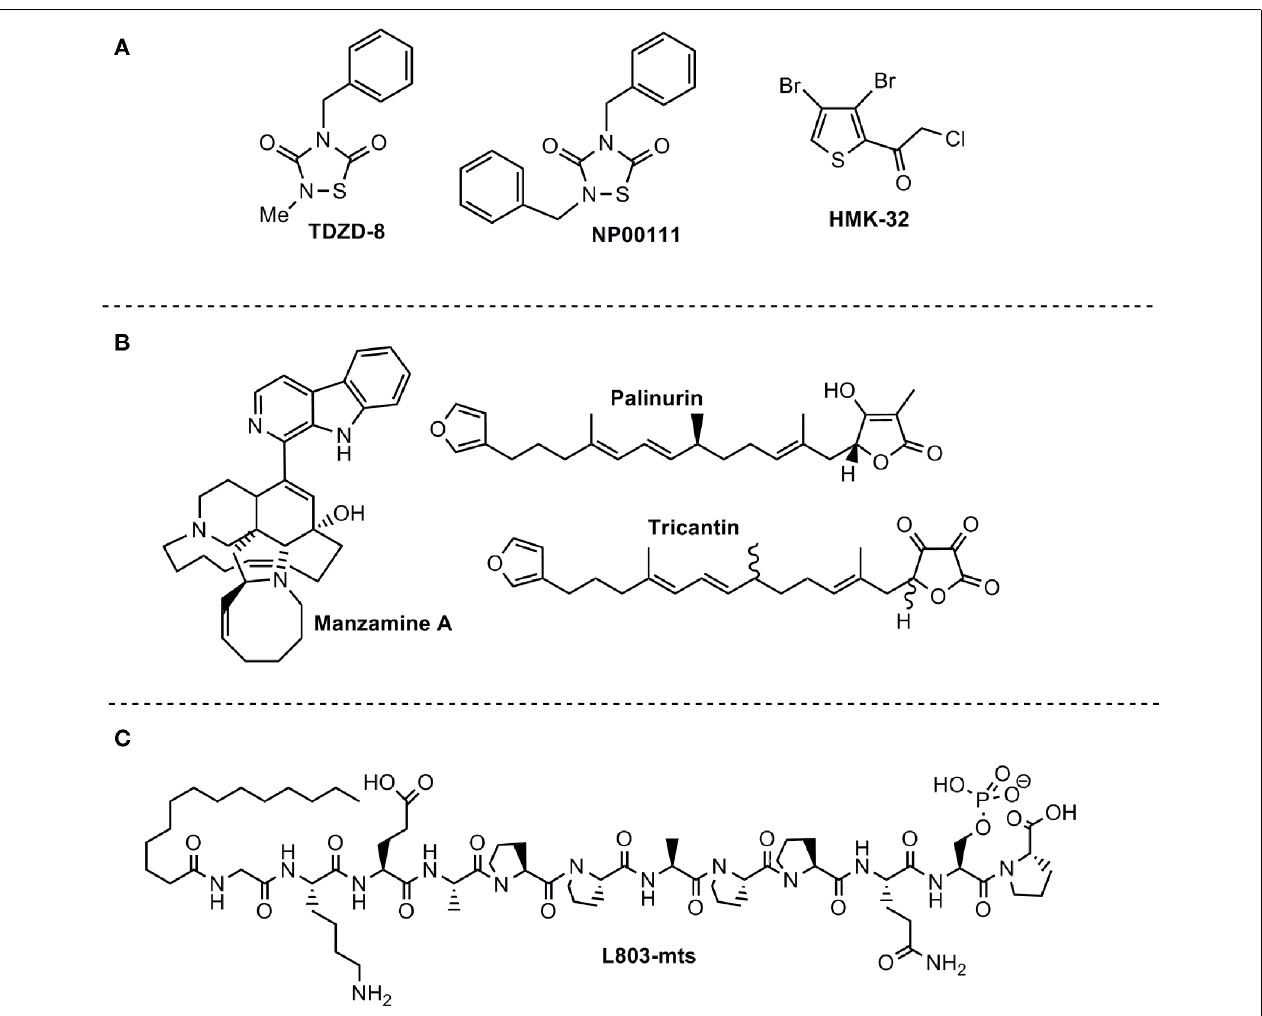
FIGURE 2 |ATP non-competitive GSK-3 inhibitors with potential for CNS disorders. (A) Small molecules from organic synthesis programs. (B) Natural compounds isolated from marine organisms. (C) Peptide competitive with substrate.